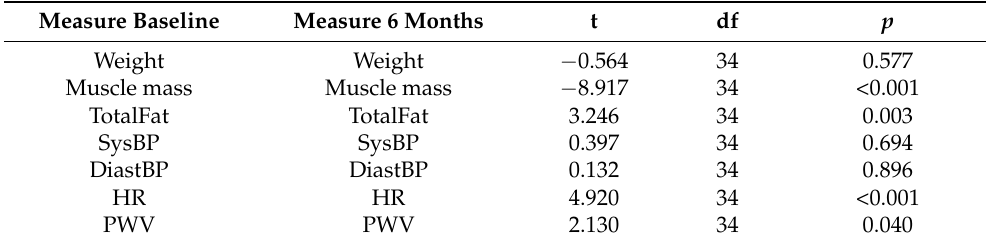
Table 3. Comparative analysis of the placebo group at baseline and six months according to the paired samples t -test.